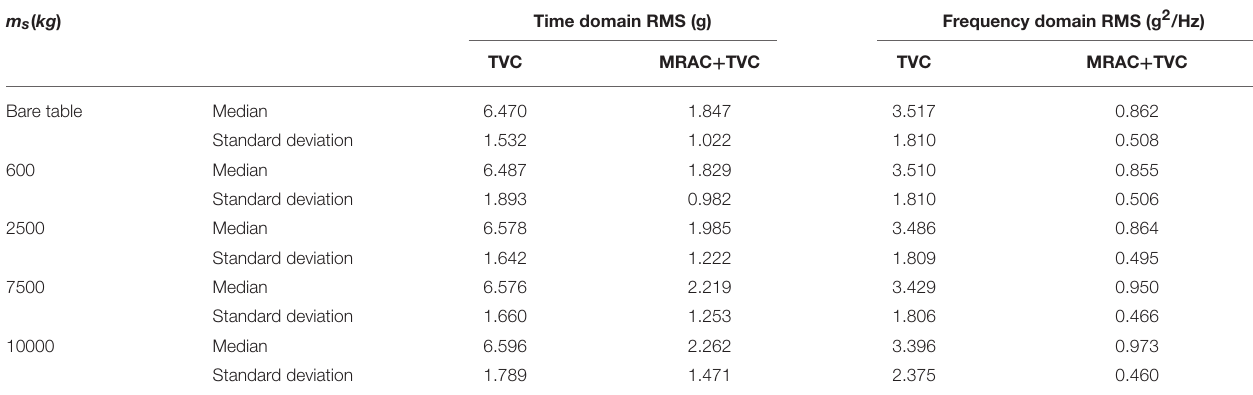
TABLE 3 | Median and standard deviation of RMS.